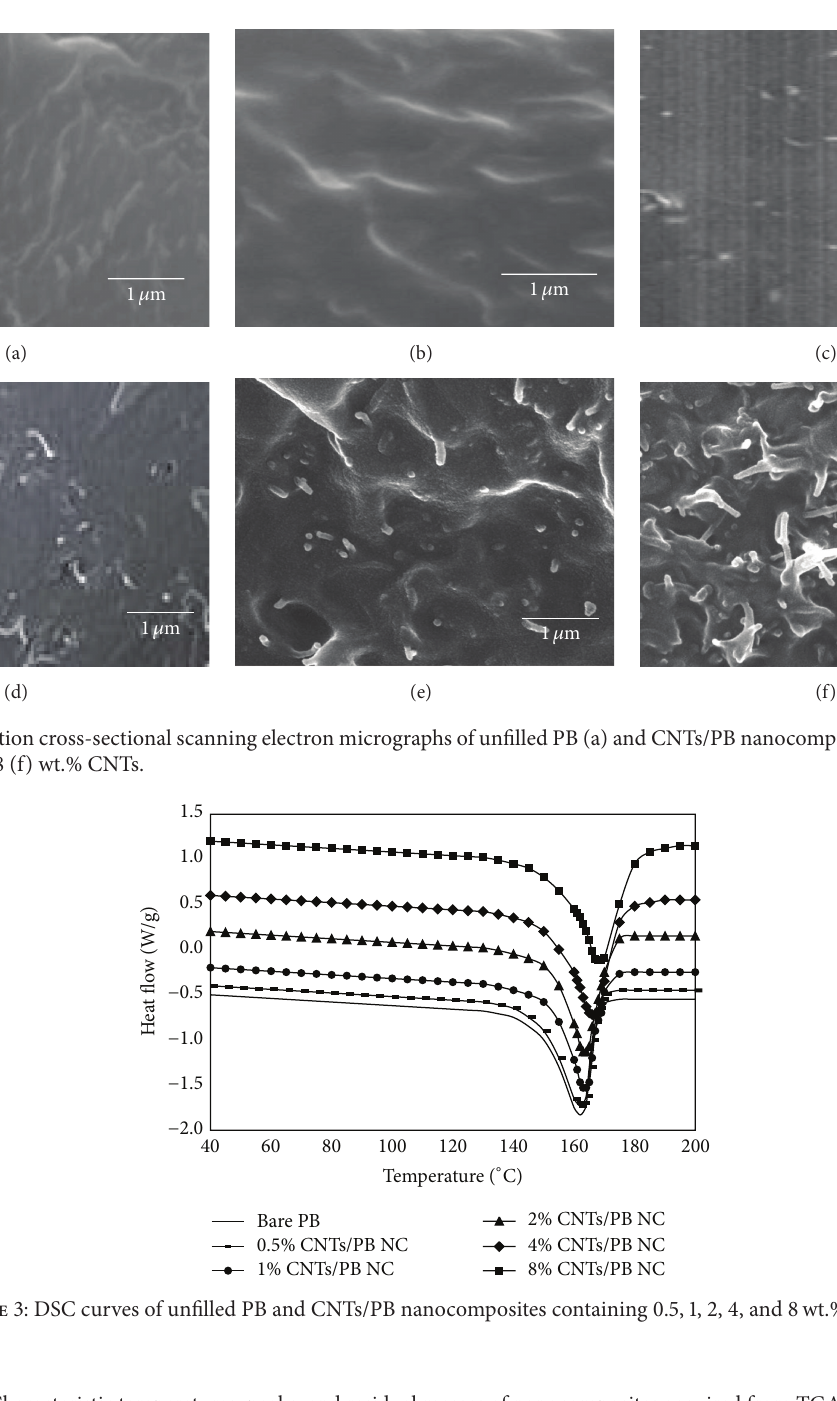
Table 1: Characteristic temperatures, peaks, and residual masses of nanocomposites acquired from TGA-DTG